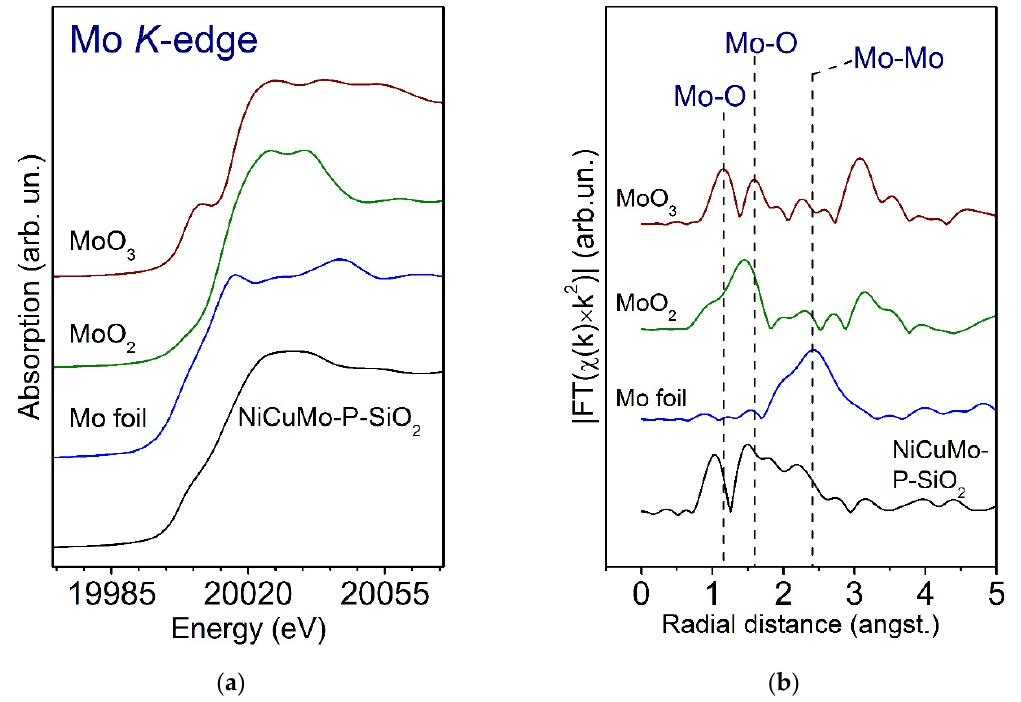
Figure 7. ( a ) Mo K-edge XANES spectra; ( b ) The module of k 2 -weighted Fourier transforms of k 2 χ (R) EXAFS-oscillations at the Mo K-edge for NiCuMo-P-SiO 2 catalyst after additional in situ reduction at 400 °C, in comparison to Mo foil, MoO 2 , and MoO 3 standards.